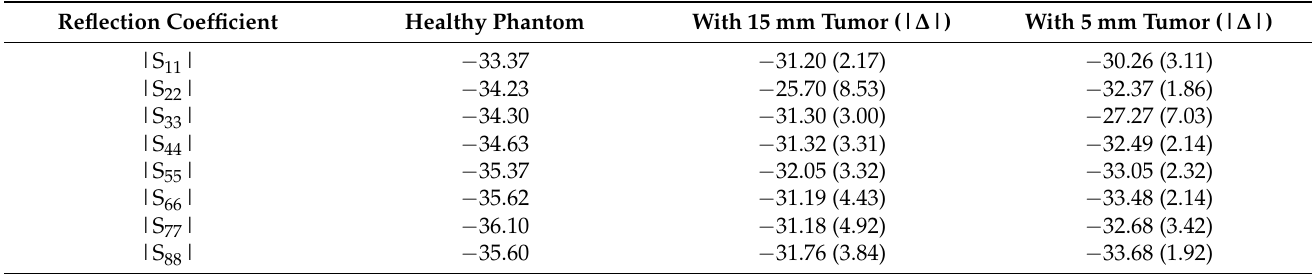
Table 3. Difference in reflection coefficient values (in dB) for phantoms with and without tumor in the phantom’s center at 3.8 GHz.